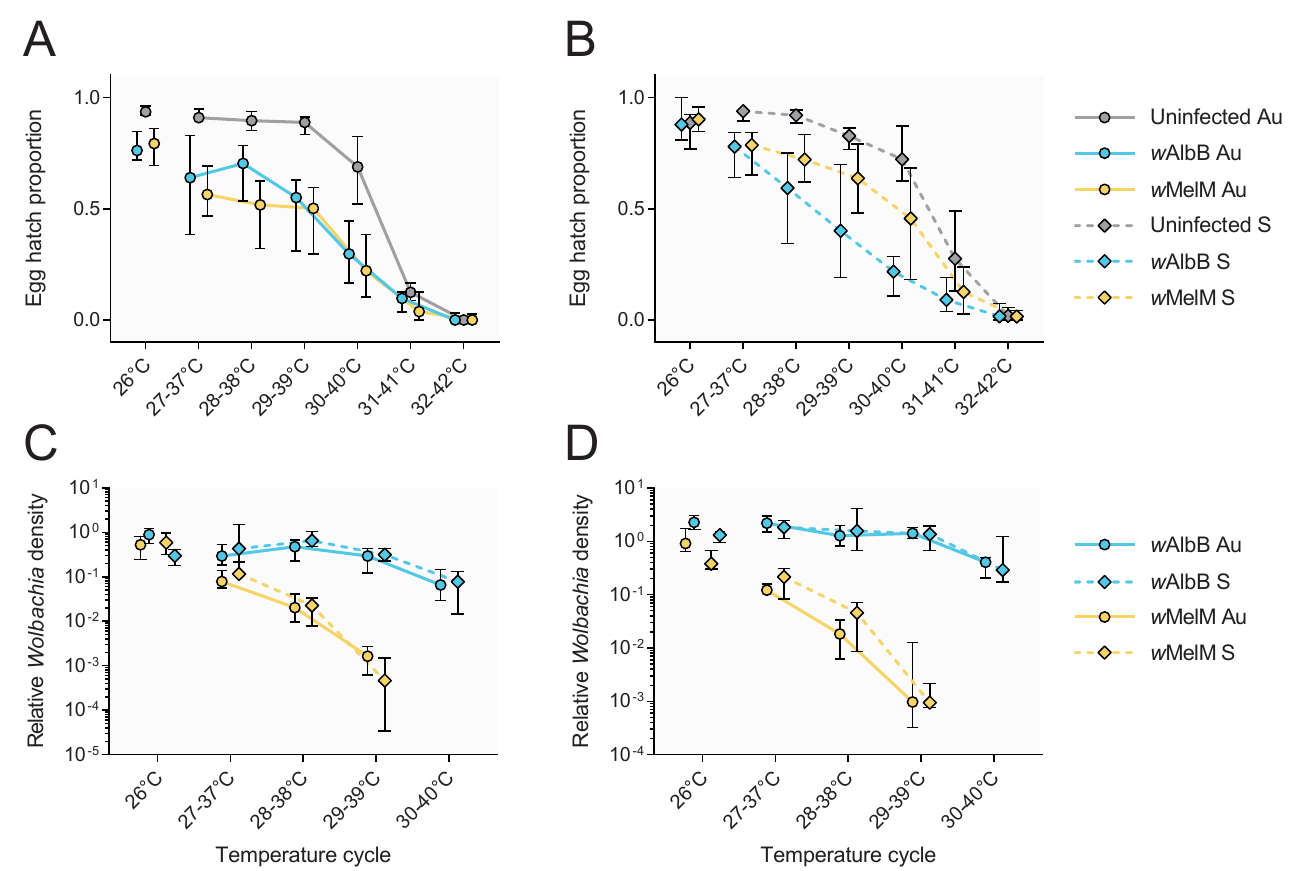
Fig 4. Effects of high cyclical temperatures on egg hatch and Wolbachia density in Wolbachia -infected and uninfected Ae . aegypti from Australian and Saudi Arabian backgrounds. Eggs were placed in thermocyclers set to 26˚C (control) or daily cycling temperatures for one week before hatching. Egg hatch proportions are presented separately for Australian (A) and Saudi Arabian (B) populations, with Wolbachia density presented separately for (C) females and (D) males. Symbols show medians, while error bars are 95% confidence intervals. Data points within each temperature cycle have been offset to avoid overlap.